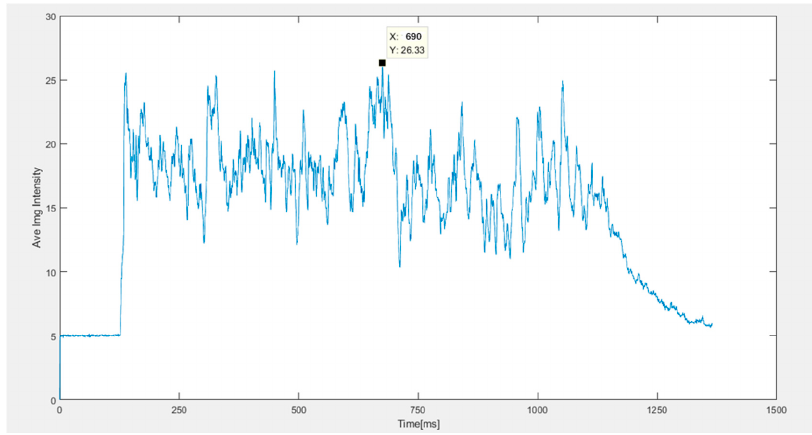
Figure 3. Average grayscale distribution of photos taken by high-speed camera. The selected photos need further post-processing. The photo displayed in grayscale was converted into a heatmap photo after color processing. The nozzle center was a ref- erence point, and the maximum distance of the upper and lower soft mist diffusion at 60 mm from the reference point was measured. Then two angles could be calculated by the arctangent function. The spray angle was the sum of the upper and lower angles and the width was the sum of two distances, as shown in Figure 4.